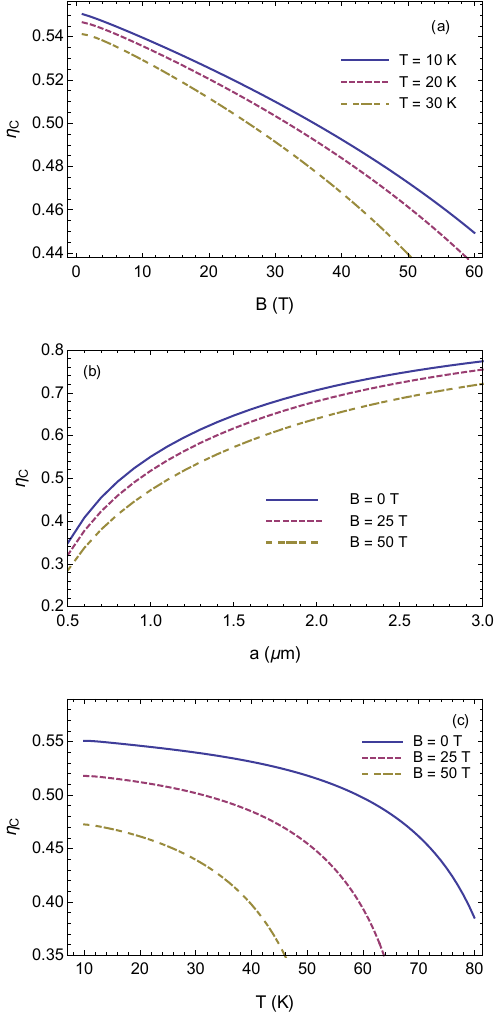
Figure 5. (Color online) Dependence of normalized Casimir force between YBCO plates in the mixed state on ( a ) magnetic field, ( b ) separation distance, and ( c ) temperature. At higher temperatures, the normalized Casimir force decreases rapidly as the mag- netic field increases. Near absolute zero, the normalized Casimir force between metallic plates, whose permittivity is described mainly by the plasma model with plasma frequency ω p , can be approximated as